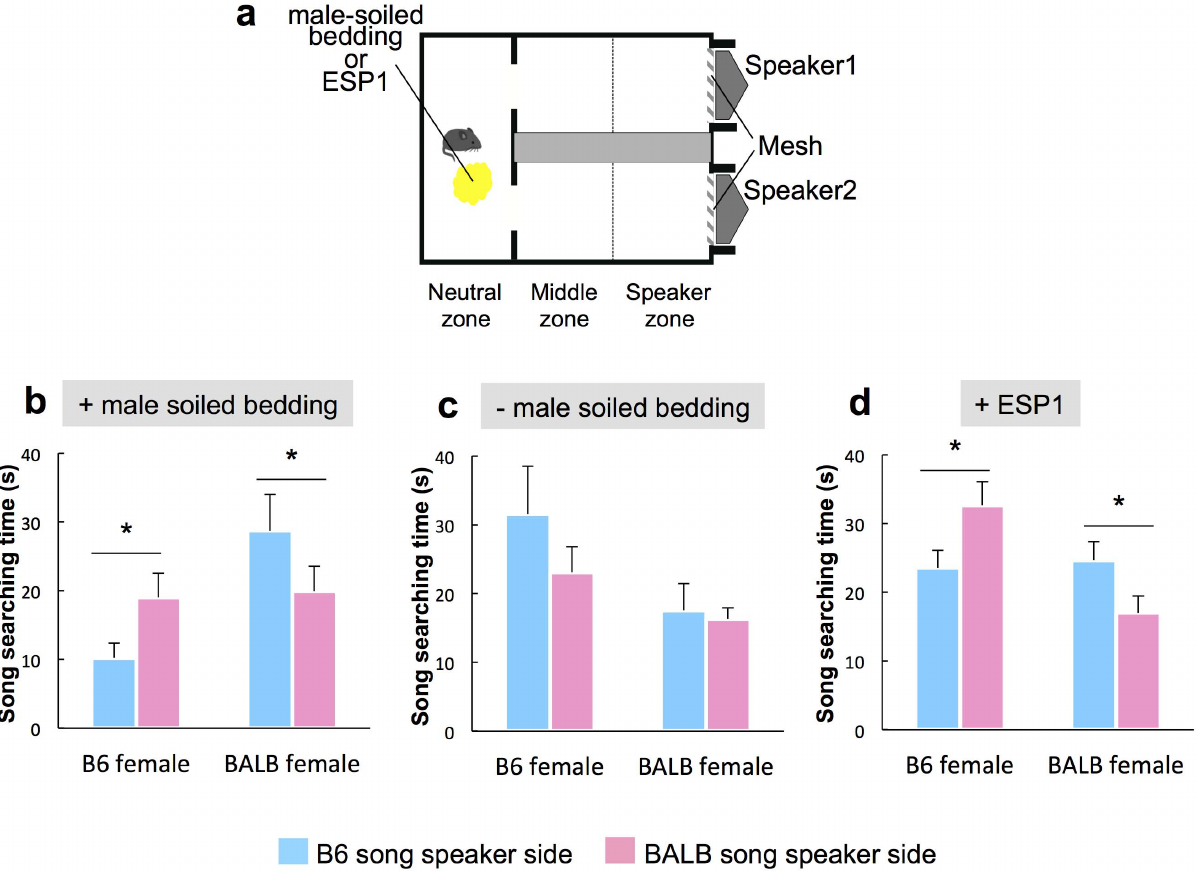
Figure 2. Female mice prefer songs of males from different strains. ( a ) Schematic of the apparatus used for the playback experiment. ( b ) B6 ( n =6) and BALB ( n =10) females in diestrus exposed to male-soiled bedding before testing showed longer-duration search times for other strains’ songs. ( c ) Duration of time searching during diestrus in B6 ( n =5) and BALB ( n =7) females in the absence of male odor before testing. ( d ) B6 ( n =11) and BALB ( n =13) females in diestrus exposed to male pheromone ESP1 before testing showed longer duration search times for other strains’ songs. Values represent means + standard error. Asterisks indicate significant differences p , 0.05.